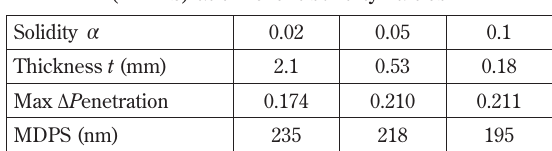
Table 5 The maximum penetration difference between spheres and agglomerates and the corre- sponding most differentiating particle size (MDPS) at different solidity values Solidity α